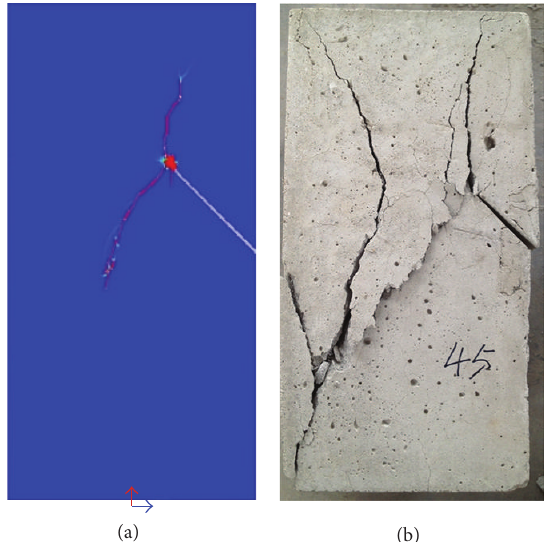
Figure 4: Failure of fissured rocks: photos and numerical simulation. Numerical simulation (a) and uniaxial compression test (b).